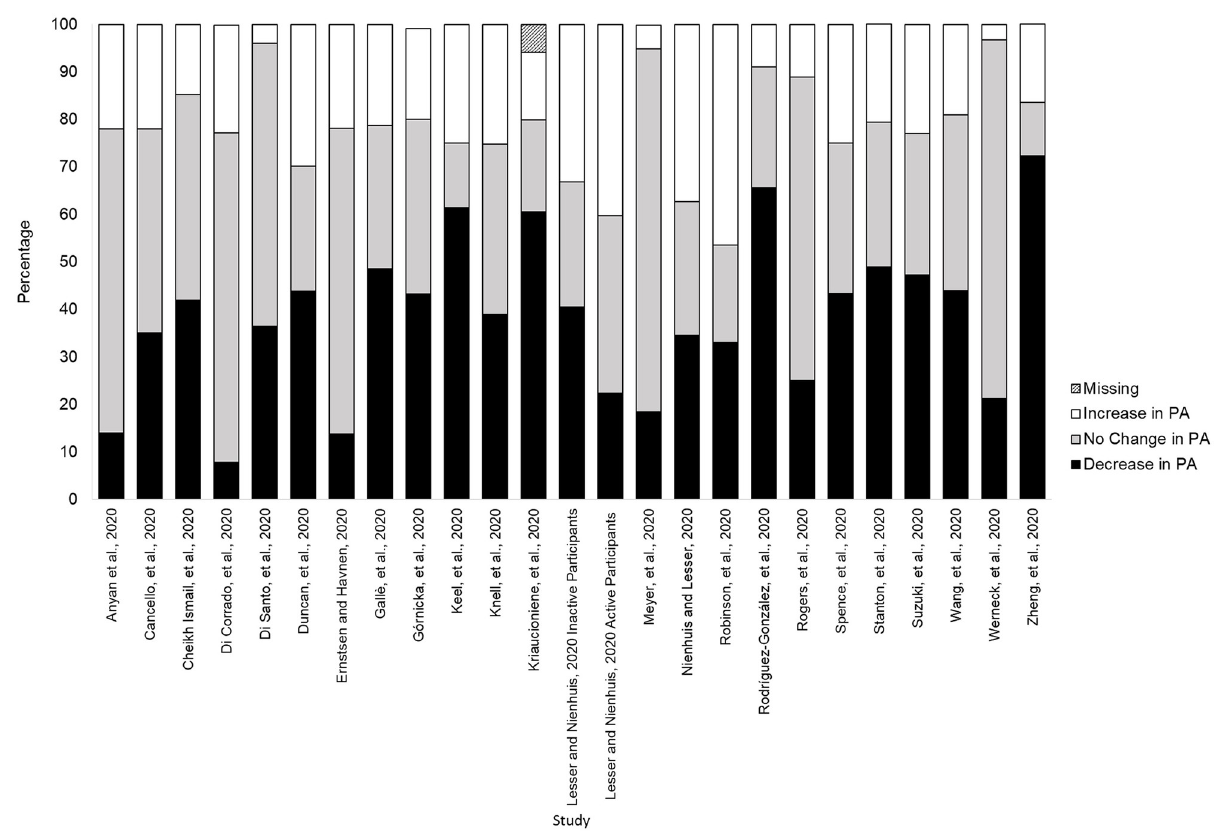
Fig 2. Studies reporting categories of change (increase, decrease, no change) in physical activity behaviour due to COVID-19.